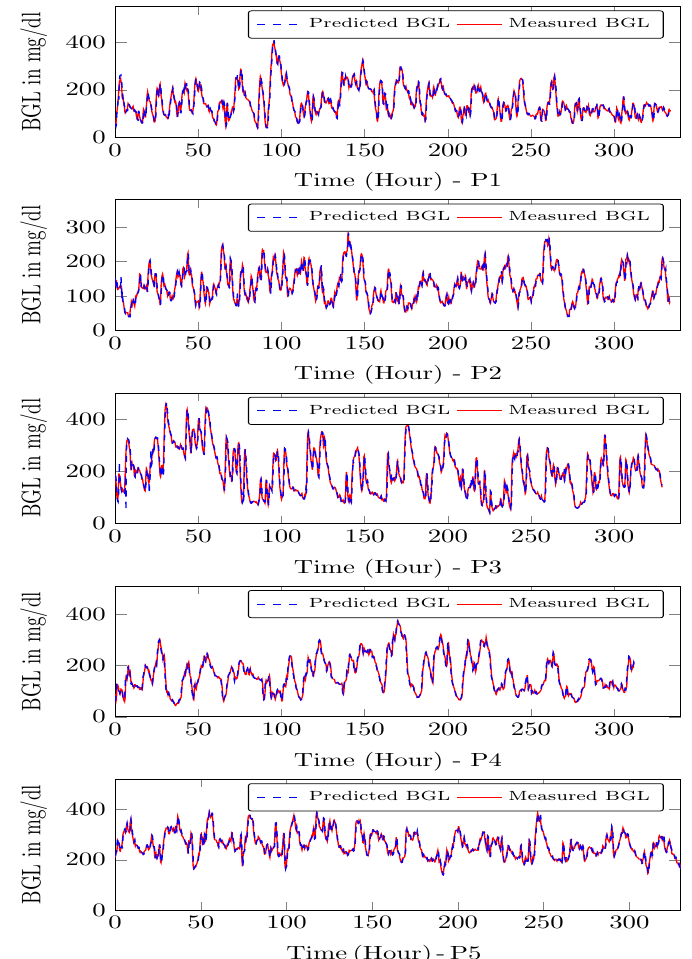
Figure 13. Model predictions for P1–P5—The time step is 15 min, and the BGL is predicted for one step